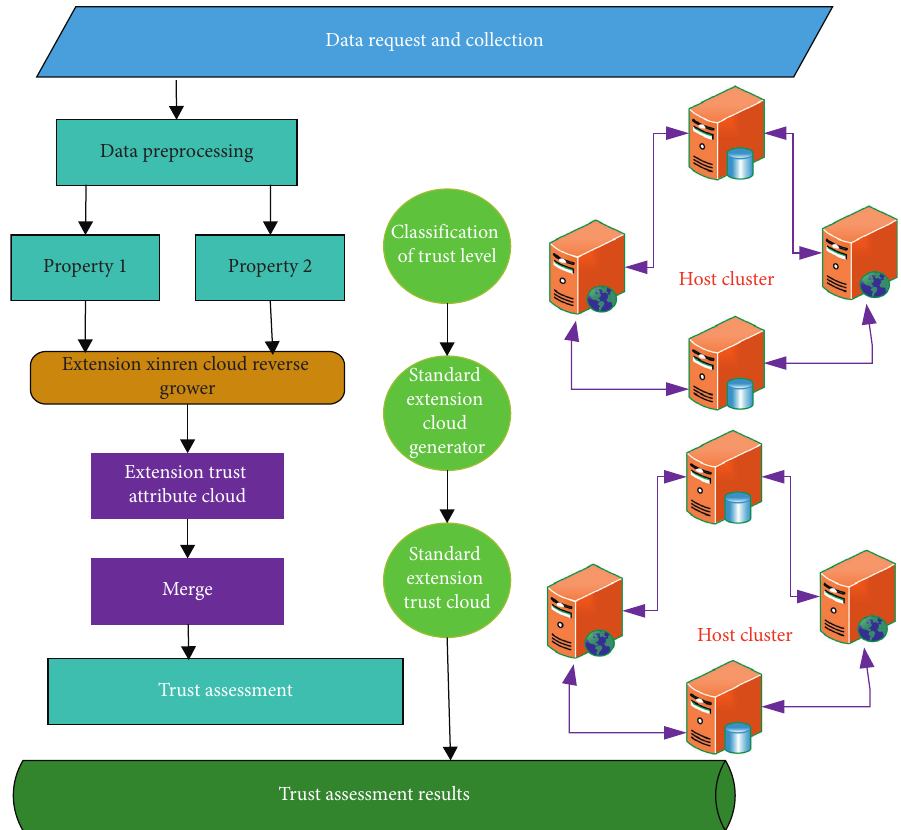
Figure 4: Trust evaluation model based on extension cloud.